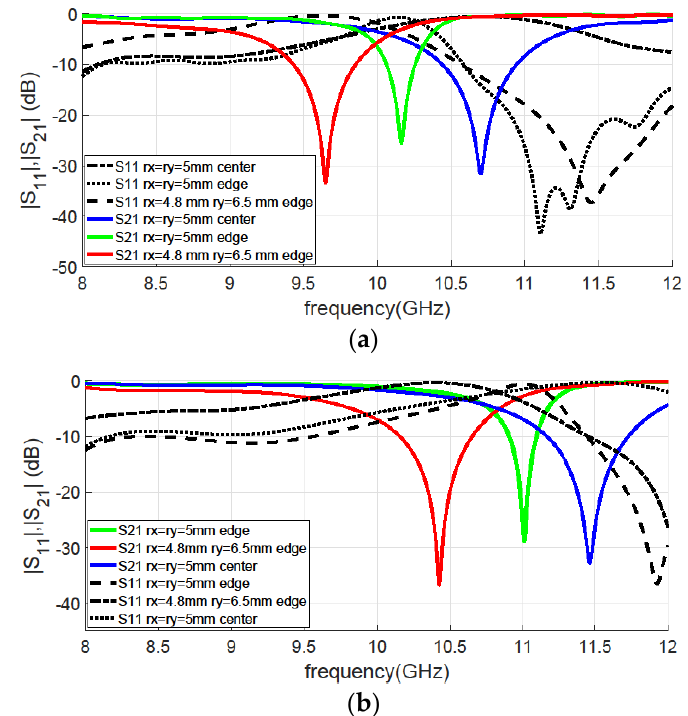
Figure 5. Simulated resonator response for different topologies (gx = 0.2 mm); square patch with central metallic via, square patch with lateral metallic via and rectangular patch with lateral metallic via with: ( a ) r = 0.6 mm and ( b ) r = 0.8 mm.